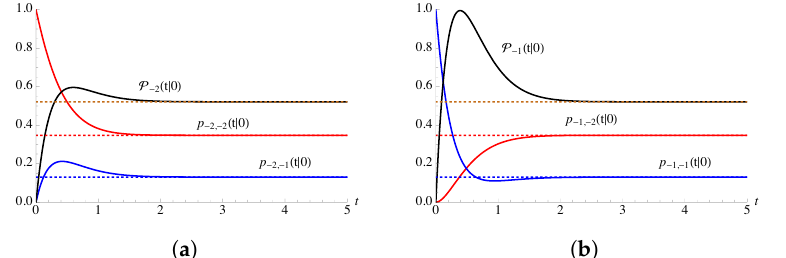
Figure 4. As in Figure 2, for ϕ ( t ) = 1 and for ξ = 1.0, (cid:36) = 1.5, ν = 4.0. In ( a ) j = − 2 (failure state) and in ( b ) j = − 1 (repair